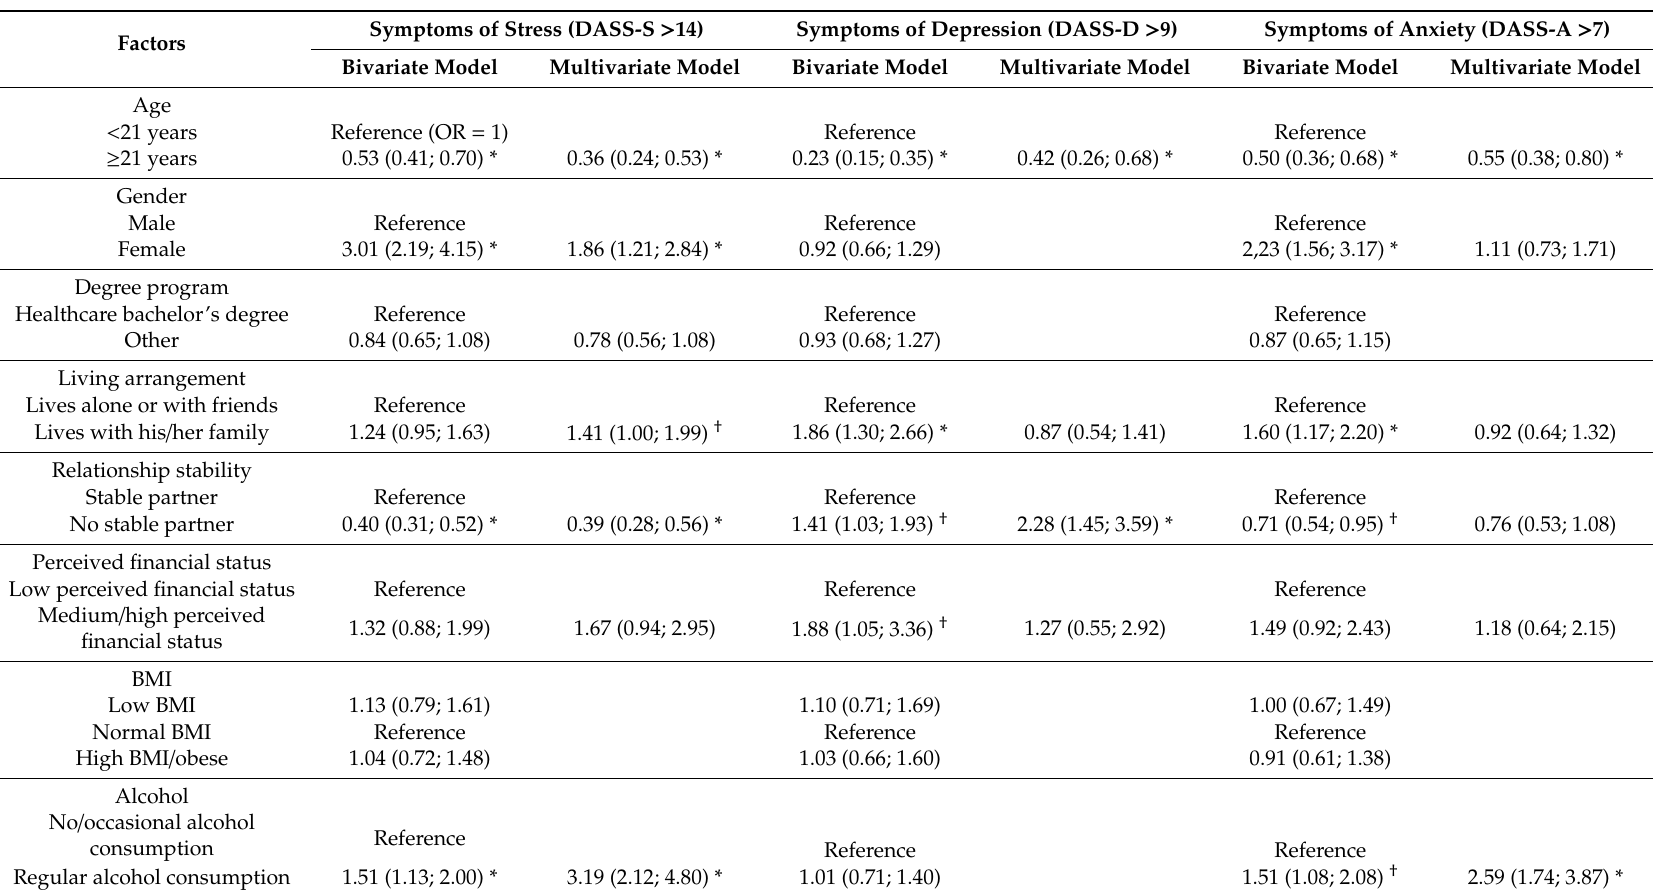
Table 3. Factors associated with symptoms of depression, anxiety and stress in Spanish college students. OR a